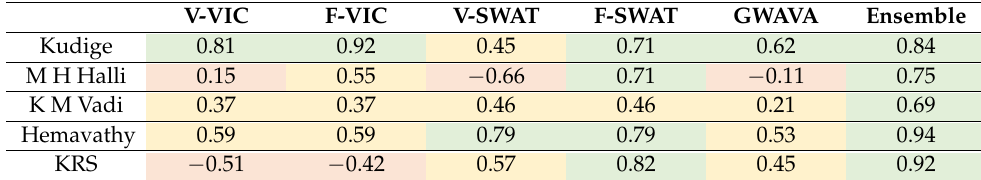
Table 2. The NSE values obtained from monthly streamflow for the five catchments for each model from 1986–2003. The values lying in the green shaded area are considered by this study as ‘good’, the yellow area as ‘fair’ and the red area as ‘poor’.